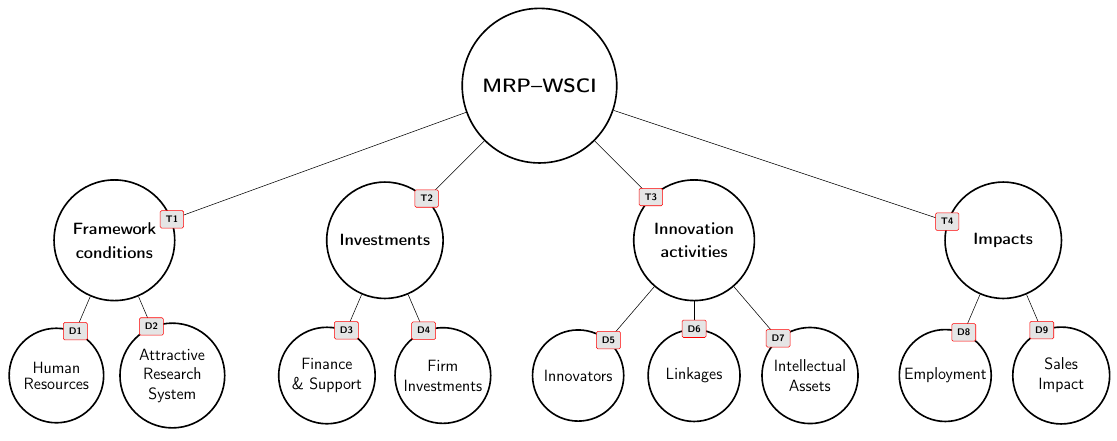
Figure 1. Hierarchy structure of the Regional Innovation Scoreborad (RIS) for three-stages of the aggregation process. The system of indicators is formed by four types, which are in turn subdivided into 9